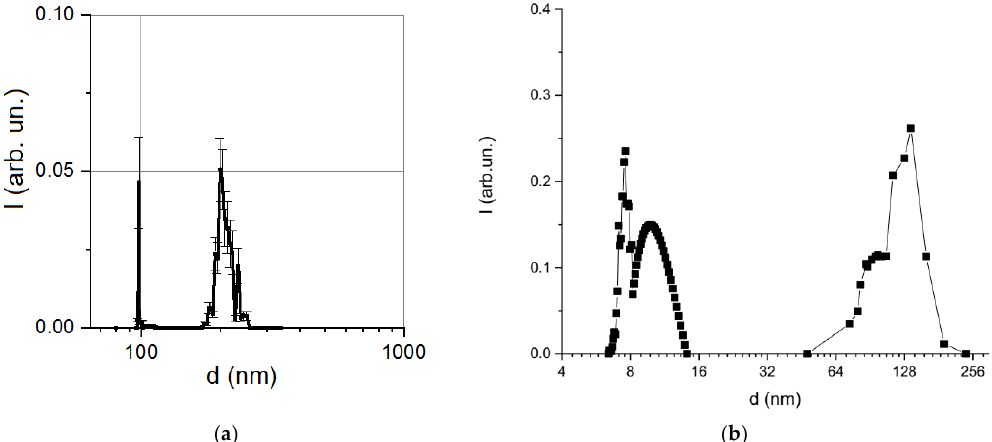
Figure 4. Comparison of particle size distribution obtained by the dynamic light scattering method: ( a ) the isolated bacterial magnetosomes; ( b ) synthetic magnetite-silica nanoparticles (reprinted from [37], Velichko, E.; Nepomnyashchaya, E.K.; Gareev, K.G.; Martínez, J.; Maicas, M.C. Characterization of Magnetite–Silica Magnetic Fluids by Laser Scattering. Appl. Sci. 2021 , 11, 183, doi:10.3390/app11010183, license CC BY 4.0).